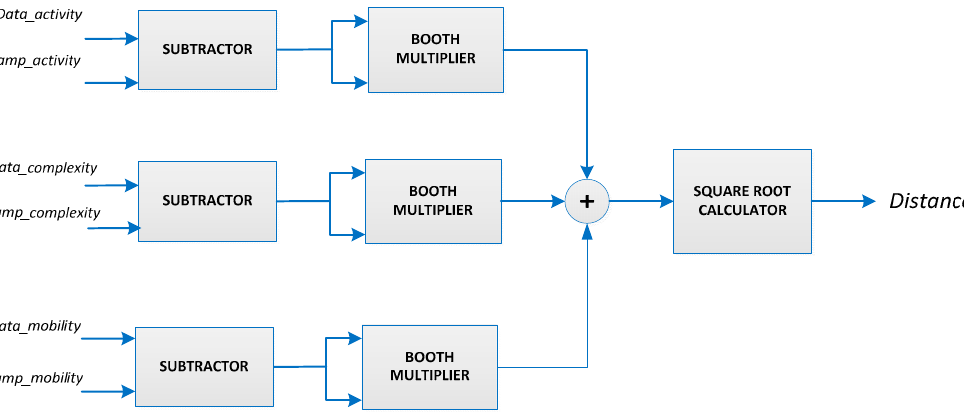
Figure 5 . Distance calculation block used to calculate distance in KNN process; all the blocks are implemented using primitive logic to support further development on different KNN configurations.